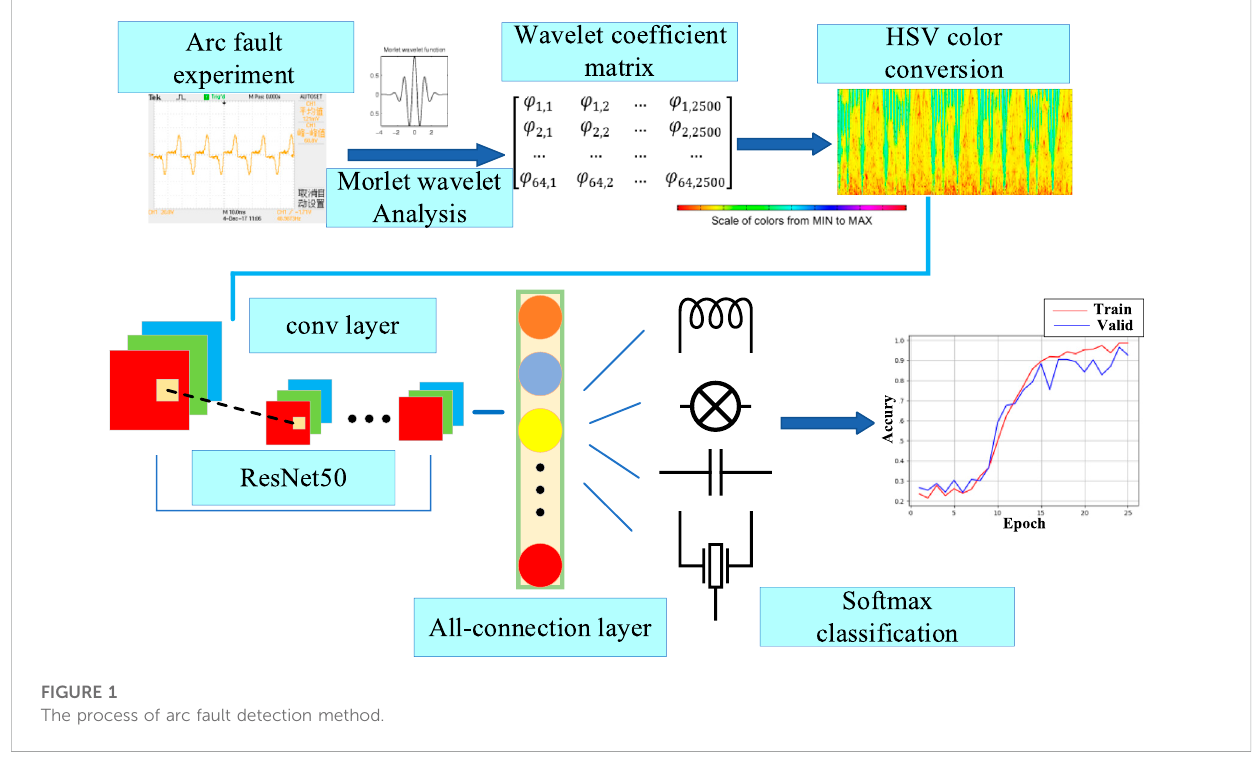
FIGURE 1 The process of arc fault detection method.